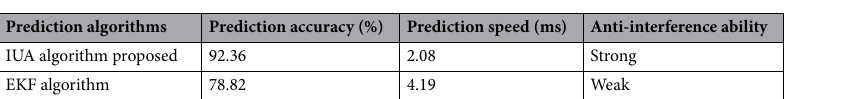
Table 1. Comparison of proposed IUA and existing EKF